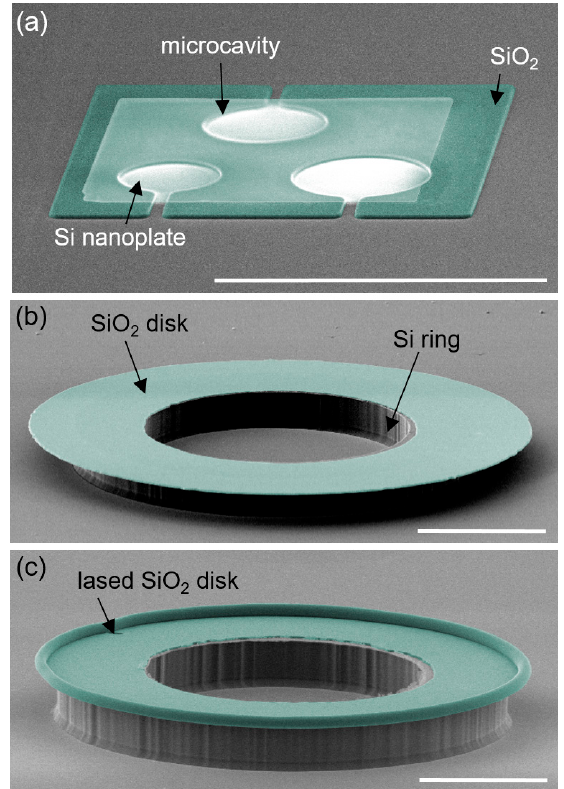
Figure 12. ( a ) A colored SEM image of a nanoplate resonating structure with an Si nanoplate assembled on SiO 2 support. Colored SEM images of ( b ) an SiO 2 disk assembled on an Si ring and ( c ) a microtoroid resonator after lasing SiO 2 disk. All scale bars represent 100 μ m. Reproduced with permission from [35].